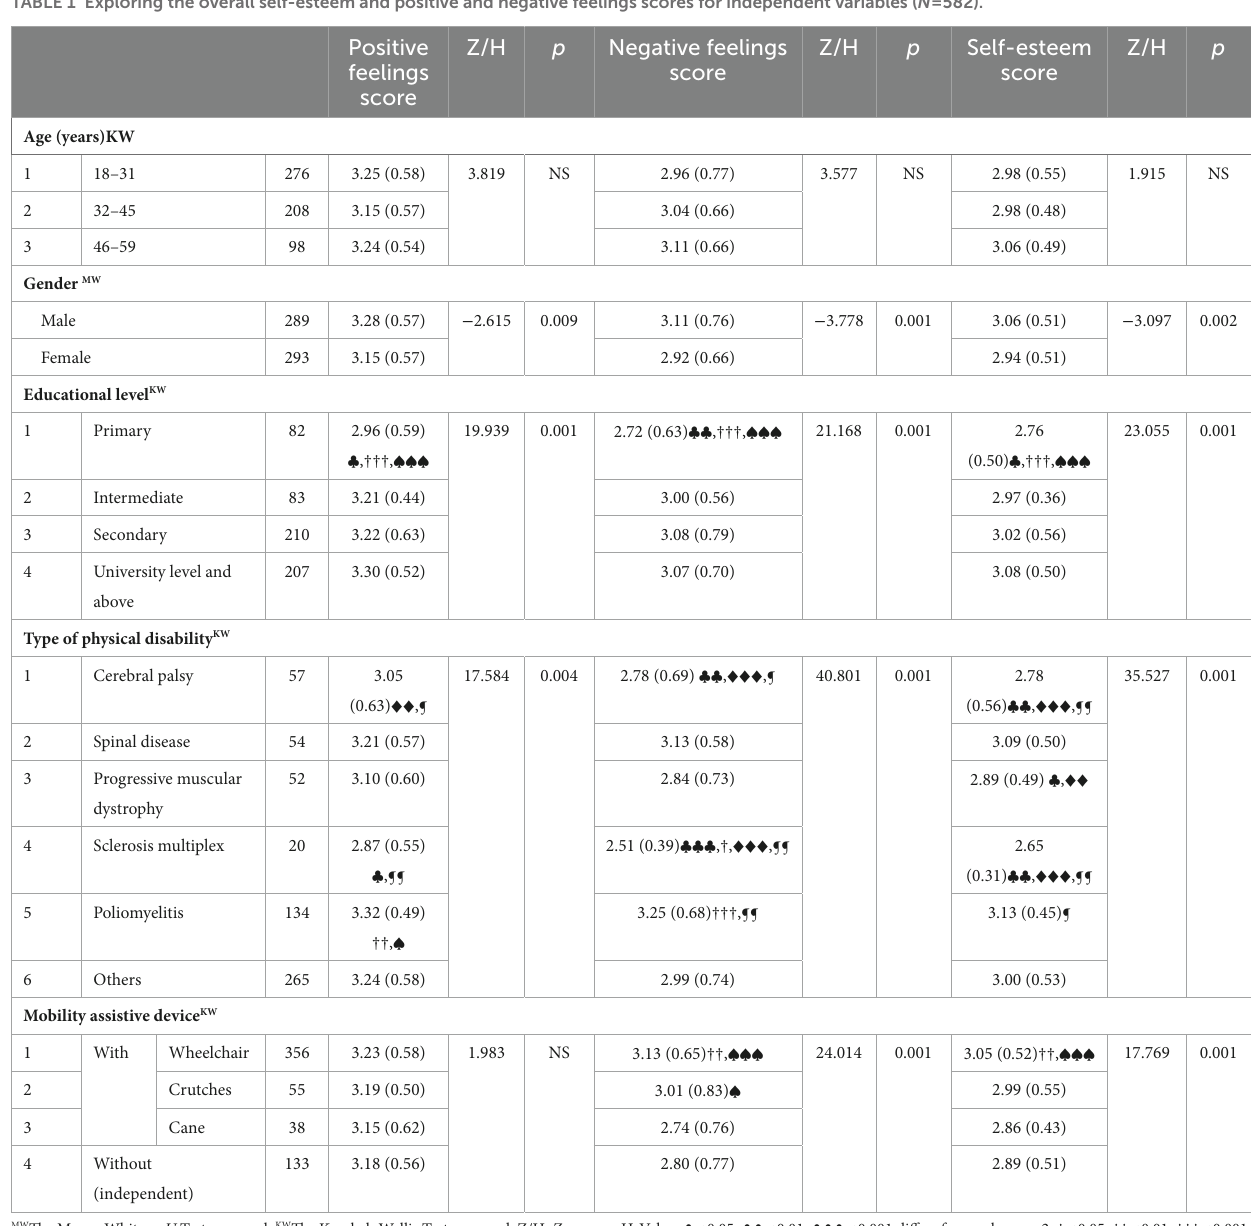
TABLE 1 Exploring the overall self-esteem and positive and negative feelings scores for independent variables ( N =